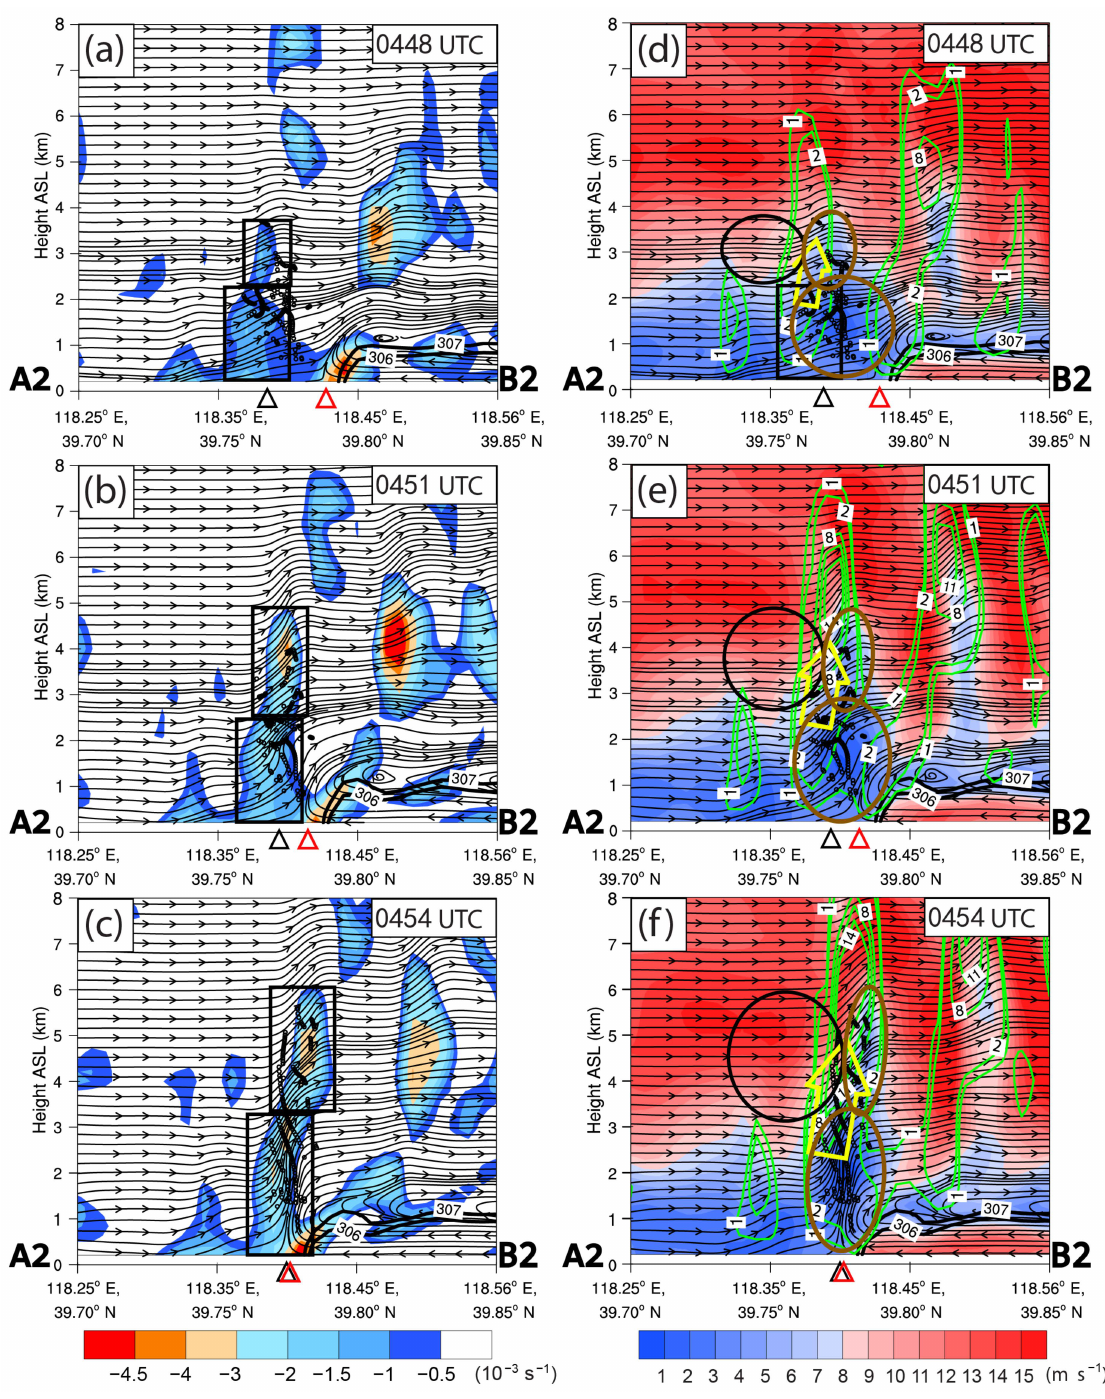
Figure 13. ( a – c ) Vertical cross section of horizontal divergence (shading, units: 10 − 3 s − 1 ) and streamline along the line segment A2B2 in Figure 10b on 31 July 2010. The small black circles indicate the location (projected to the vertical cross section) of the air parcels. The two black rectangles indicate the significant convergence regions in different levels. The black and red triangle symbols indicate the locations of the leading edges of the SBF and GF, respectively. The specific time is shown in the upper right corner of each panel; ( d – f ) are the same as ( a – c ) but for the horizontal wind velocity (HWV) (shading, units: m s − 1 ) and vertical wind speed (green contours, units: m s − 1 ). The black ellipses indicate the near-upstream high-wind region , while the bold brown ellipses showed the weak-wind regions in different